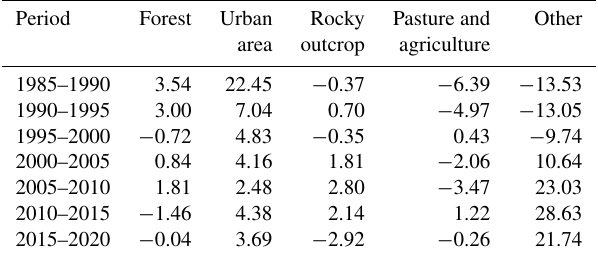
Table 3. Percentage of change in LULC classes over 5-year periods for the Petrópolis municipality.